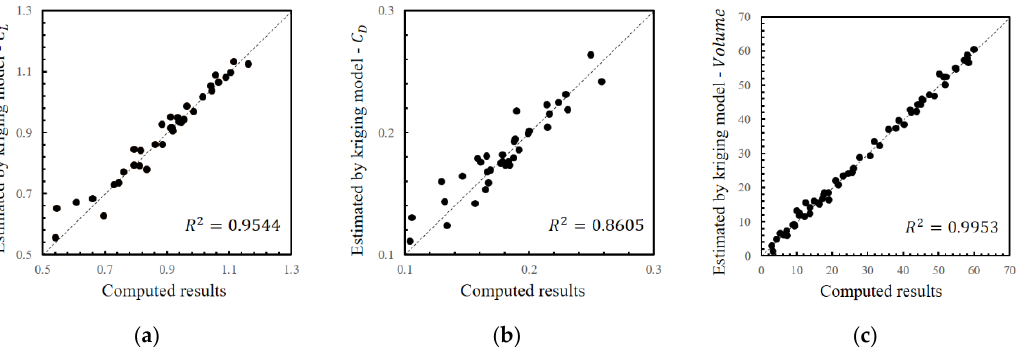
Figure 9. Cross-validation data required for the kriging model; ( a ) lift coefficient; ( b ) drag coefficient; ( c ) internal volume.